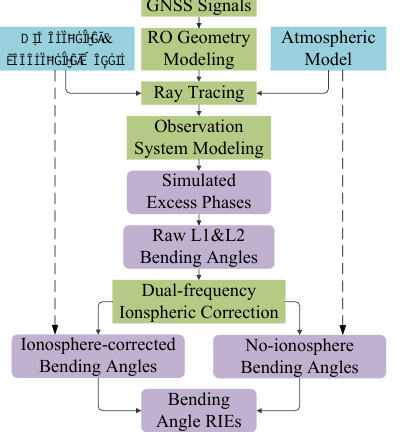
Figure 2. Flow chart of the RO end-to-end simulation process for bending angle RIEs; for a description see Sect. 2.2.